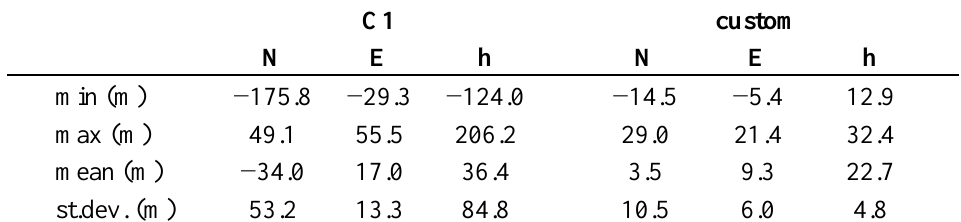
Table 3. Statistics of the worst and best indoor